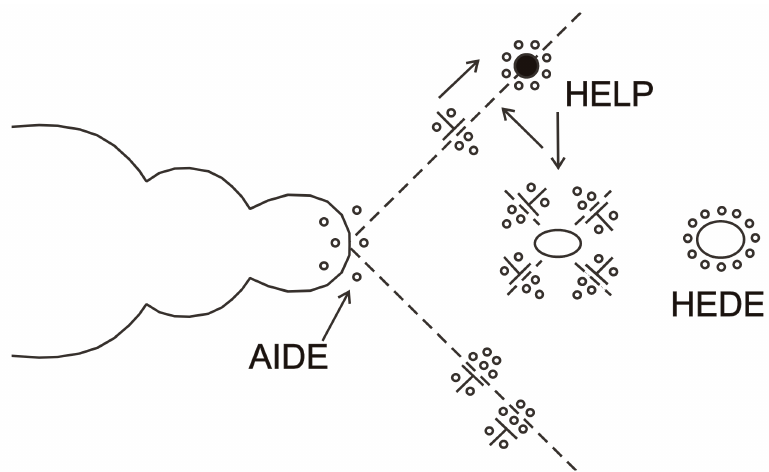
Figure 1. Schematic illustration of three hydrogen embrittlement mechanisms: Hydrogen-Enhanced Localized Plasticity (HELP), Hydrogen-Enhanced Decohesion (HEDE) and Adsorption-Induced Dislocation Emission (AIDE) [12].